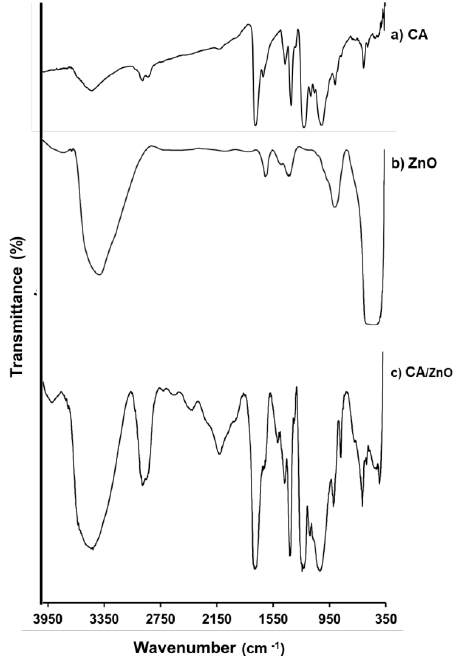
Figure 2. Thermogravimetric analysis of CA and CA/ZnO membranes.